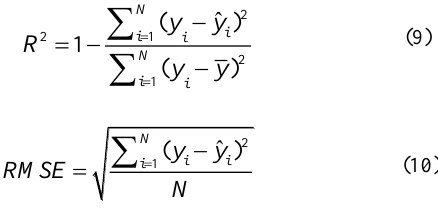
Four determinant indicators are used evaluate the fitting and generalization ability of the model: the coefficient of determination (R 2 ), the root-mean-square error (RMSE), the residual prediction deviation (RPD), and the ratio of prediction performance to interquartile range (RPIQ), which are defined